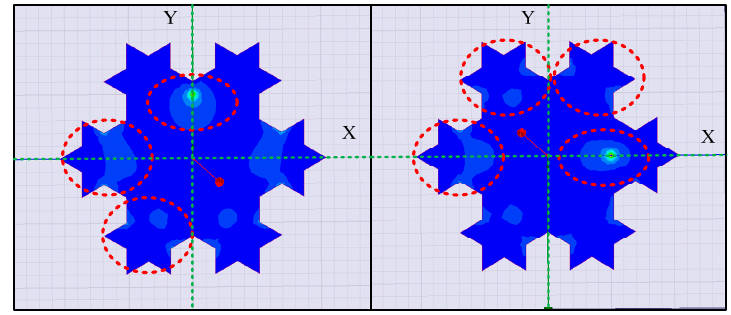
6 of 15 Table 1. Resonant points and minimum standing wave ratio at different feed position. Feed Point